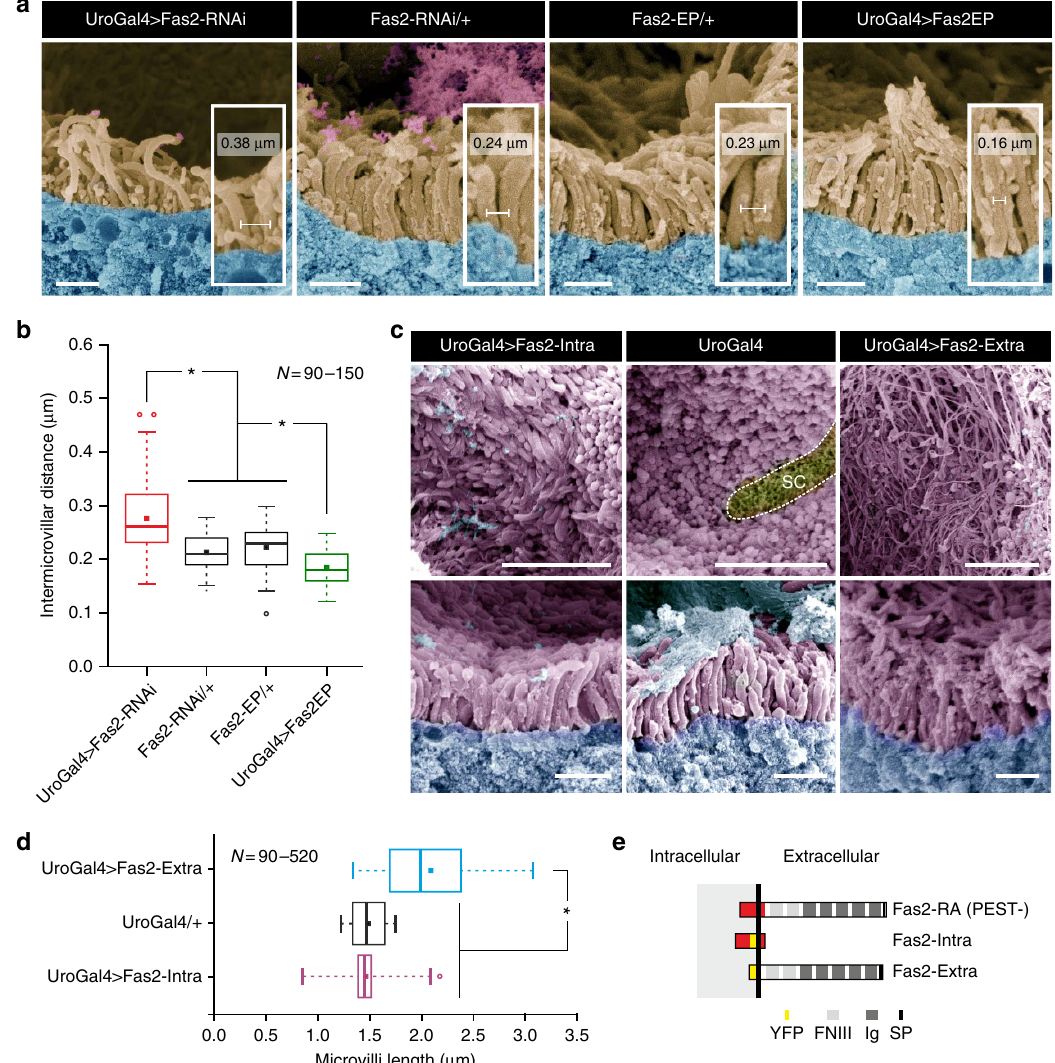
Figure 4 | Genetic manipulation of Fas2 impacts microvilli organization. ( a ) Scanning electron microscopy (SEM) analysis of microvillar organization. Microvilli (pseudo-coloured light brown) from parentals (Fas2-RNAi/ þ and Fas2-EP/ þ ) show distinct well-organized bundles of microvilli, whereas in Fas2 knockdown flies (UroGAL4 4 Fas2-RNAi) the microvilli tend to appear as single distinct protrusions. Overexpressing Fas2 makes the bundles more obvious, and the microvilli often appearing more densely packed (UroGAL4 4 Fas2-EP). Inter-microvilli distances were measured (see inserts) from ( N ¼ 6–10) cross-sections with ( N ¼ 90–150) microvilli measured in total for each Fas2 genetic background. Scale bars, 1 m m. ( b ) Tukey box and whisker plot of intermicrovillar distances from the different fas2 genetic backgrounds. Genetic manipulations of Fas2 expression levels significantly change (*, one-way ANOVA, P o 0.05) the average distance between the individual microvillar protrusions compared with parental controls. Intermicrovillar distance was measured (see inserts) from ( N ¼ 6–10) cross-sections with ( N ¼ 90–150) distances measured in total for each Fas2 genetic background. Solid squares indicate mean values; open circles symbolize data outliers. ( c ) Independent overexpression of the Fas2 extracellular domain (Fas2-Extra–YFP) results in a phenotype comparable to overexpressing the full-length transcript (although areas of the brush border showed an excess of adhesion-activity compared with parental controls), whereas overexpression of the Fas2 intracellular domain (Fas2-Intra–YFP) results in microvilli being indistinguishable from controls. Top tier images represent face-on views, whereas bottom tier images are cross-sectional views of the brush border from the various genetic backgrounds. SC, stellate cell (yellow). Scale bars, 5 m m and 1 m m, respectively. ( d ) Tukey box and whisker plot of microvilli length from the selective overexpression of the Fas2 extracellular and intracellular domains, respectively. Overexpression of the extracellular domain significantly changes (*, one-way ANOVA, P o 0.05) the average microvillar length compared with overexpression of the intracellular domain and parental controls. Individual microvilli were measured from ( N ¼ 5–10) cross-sections with ( N ¼ 90–520) microvilli measured in total for each Fas2 genetic background. Solid squares indicate mean values; open circles symbolize data outliers. ( e ) Schematic diagram of native full-length Fas2-RA (PEST-) and the YFP-tagged Fas2-Intra and Fas2-Extra constructs (adapted from ref.